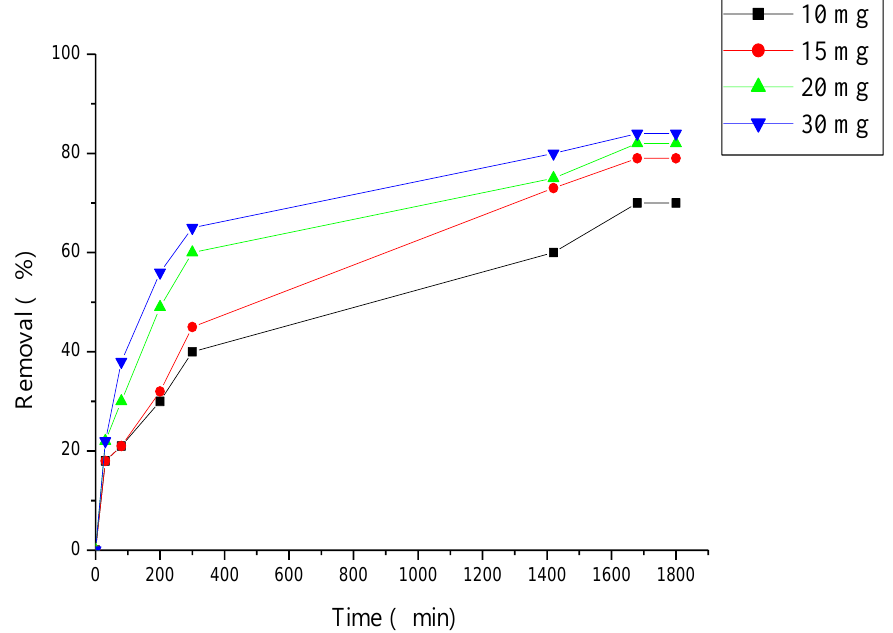
Figure 7. Effect of ß-cyclodextrin polymer amount on methyl violet removal, pH = 4, T = 30 ◦